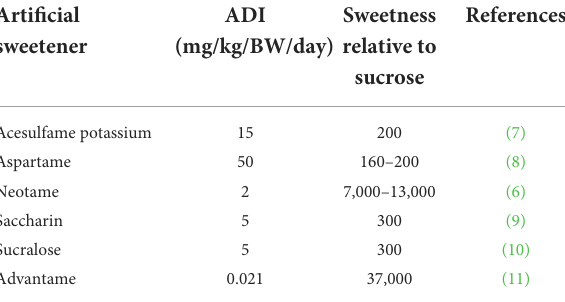
TABLE 1 ADI and sweetness of artificial